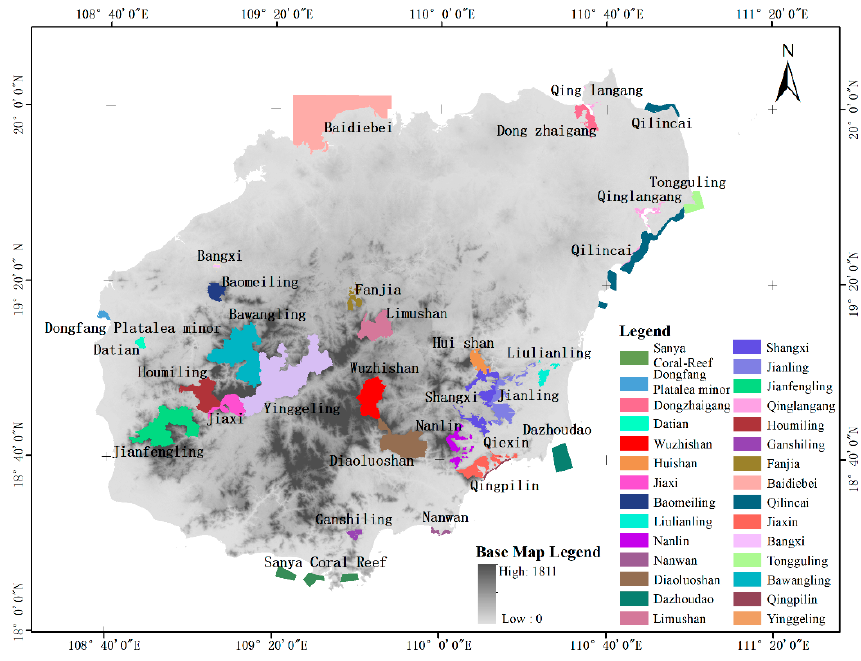
Figure 1. Distribution of 29 provincial and national nature reserves at Hainan Island.